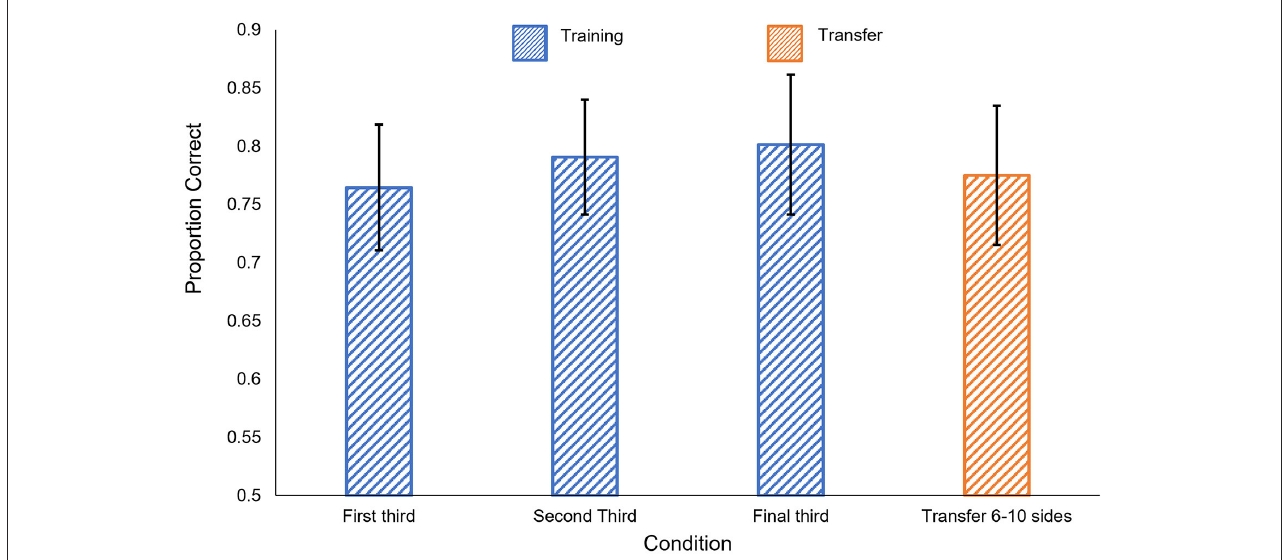
FIGURE10 Human results in Experiment 3c. Blue: performance in the training phase, separated into 50-trial blocks. Orange: performance on the generalization tests. Error bars show ± one standard error of the mean.